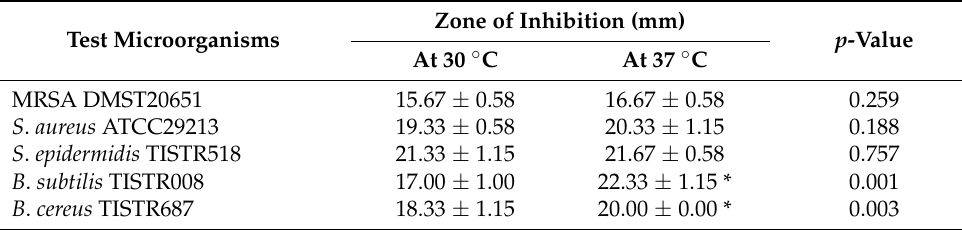
Table 2. Inhibition zone diameter of crude ethyl acetate of Streptomyces sp. PJ85 collected at day 5 of cultivation.